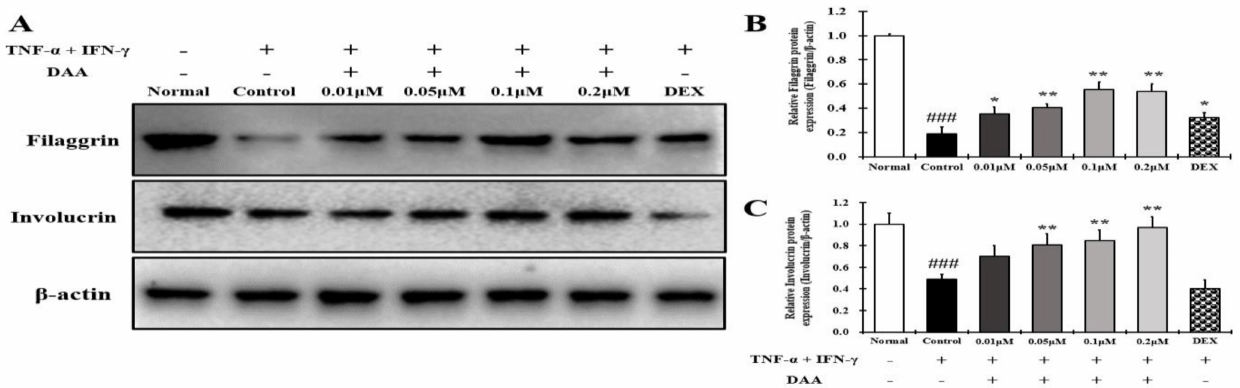
Figure 10. Effect of DAA on the protein expression levels of filaggrin (FLG) and involucrin (IVL) in HaCaT cells. ( A ) DAA increased the expression of filaggrin and involucrin. ( B ) Quantified values of filaggrin. ( C ) Quantified values of involucrin. The levels of filaggrin and involucrin were normalized to that of β -actin. The results are expressed as the mean ± SD (n = 4). ### p < 0.001 vs. normal; * p < 0.05 and ** p < 0.01 vs. control. DAA was used at 0.01 µ M, 0.05 µ M, 0.1 µ M, and 0.2 µ M. DEX, the positive control, was used at 0.1 µ